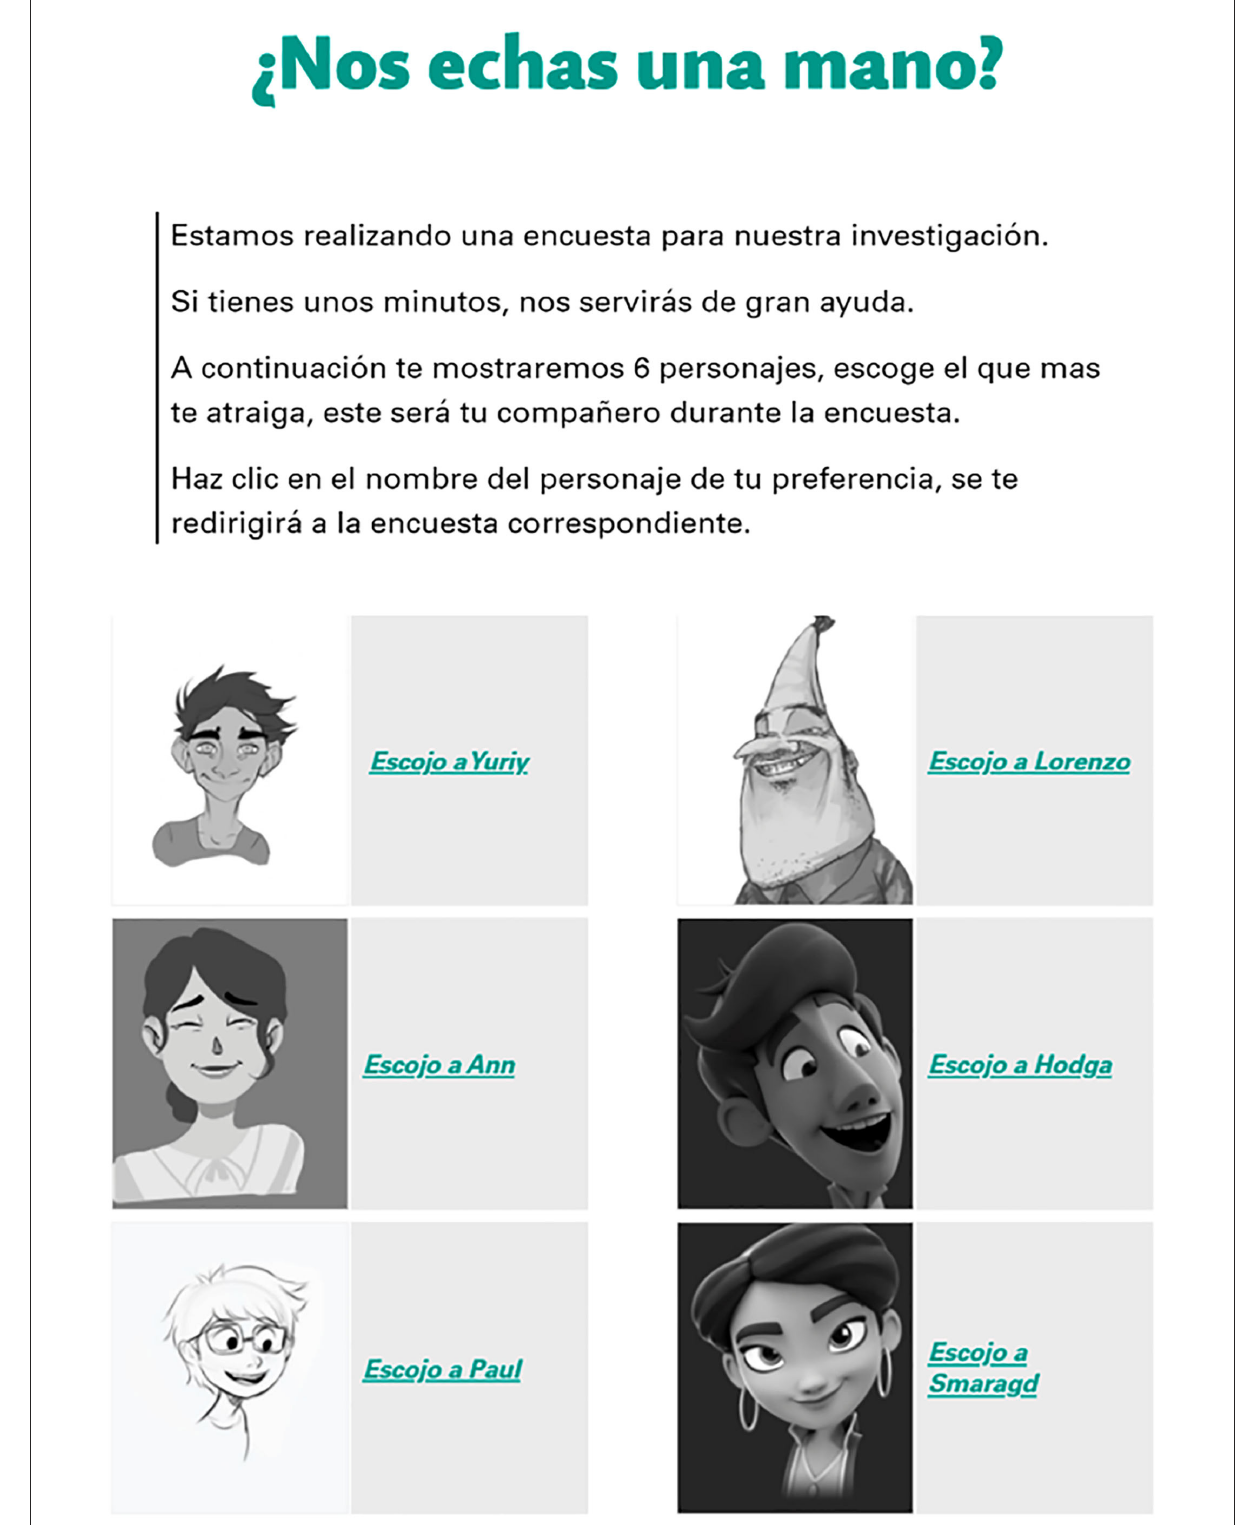
FIGURE3 Welcome page for the questionnaire showing the characters (elaborated based on images from authors cited in Table 1).